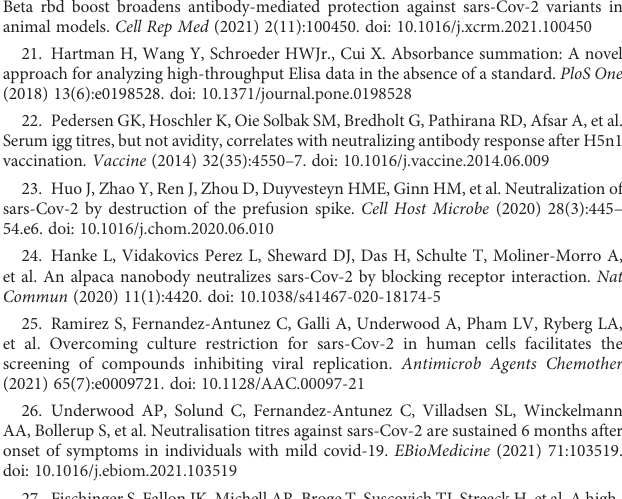
post-infection against full spike protein from (A) the homologous Wuhan-Hu-1 strain and (B) the omicron (B.1.1.529. variant. SUPPLEMENTARY FIGURE 3 Syrian golden hamsters were immunized with two doses of spike trimer protein formulated in aluminium hydroxide given either as an accelerated regimen (10 days apart) and sampled at 11 days after the 2 nd immunization or as a normal regimen (21 days apart and sampled 21 days after the 2 nd immunization. Antibody dependent complement deposition was measured by coating beads with spike protein. Sera from vaccinated or non- vaccinated hamsters and complement was added and antibody- dependent complement deposition was assayed by measuring C3 deposition by fl ow